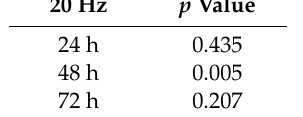
Table 1. The p -value of the percentage of viable mouse glioma cell line CT2A cells after exposure to a 100 µ T electromagnetic field (EMF) at 20 Hz.